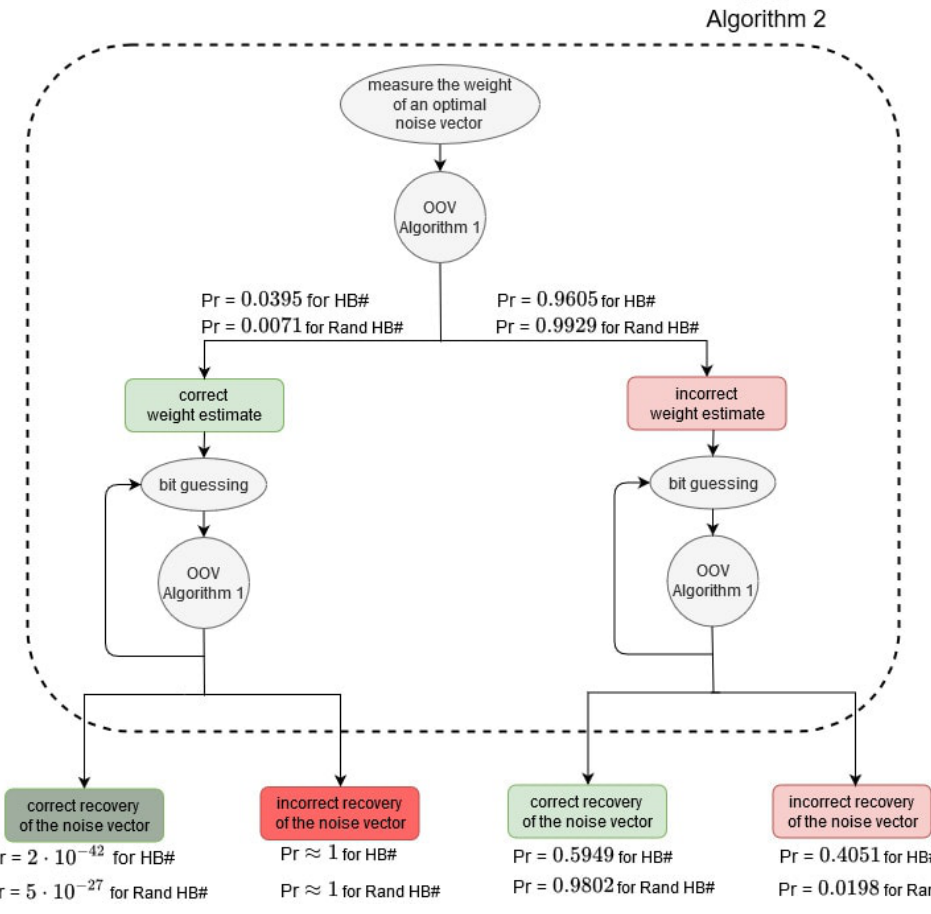
Figure 4. Probability of correct noise vector recovery (Algorithm 2) in the OOV attack depends on mutual cancelation of errors produced by Algorithm 1. If the weight of a noise vector has been correctly measured, the probability that Algorithm 2 will correctly recover the bits of the vector is negligible. Practically, the only way Algorithm 2 can recover the noise vector is that to initially incorrectly estimate its weight, and then rely on the fact that the error made in the bits guessing procedure can neutralize the previous